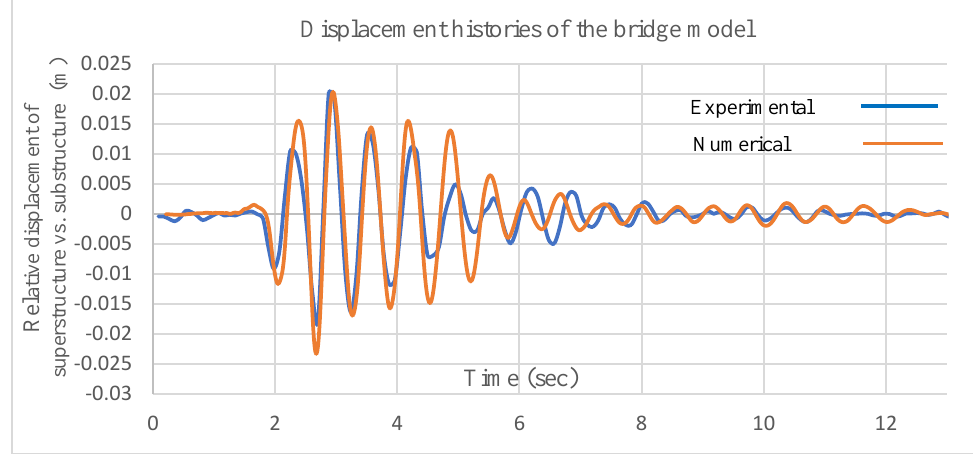
Figure 13. Displacement histories of the superstructures against substructure (bearings displacement) under Northridge earthquake with PGA = 0.2 g.